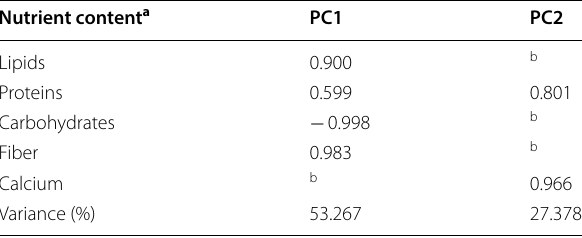
Table 4 Component loadings and variance proportions explained in a principal component analysis for nutrient